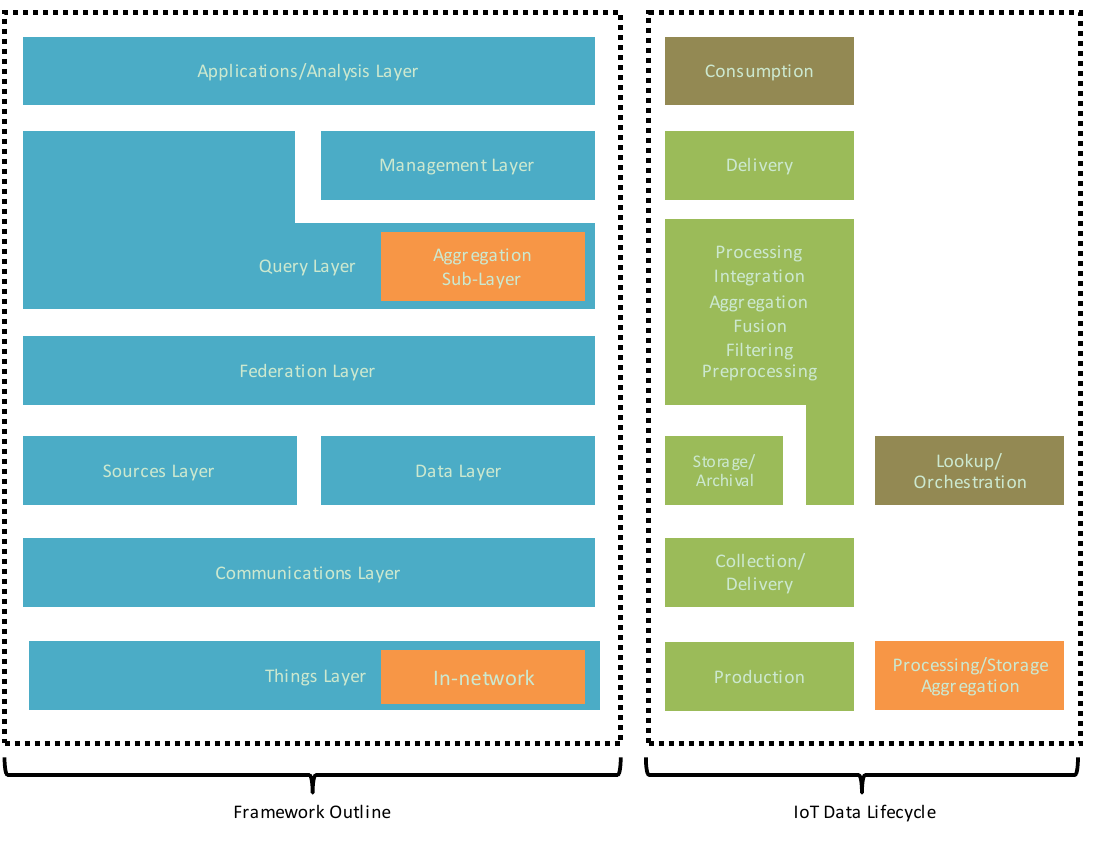
Figure 3. Outline of the proposed IoT data management framework and mapping of its layers to the IoT data